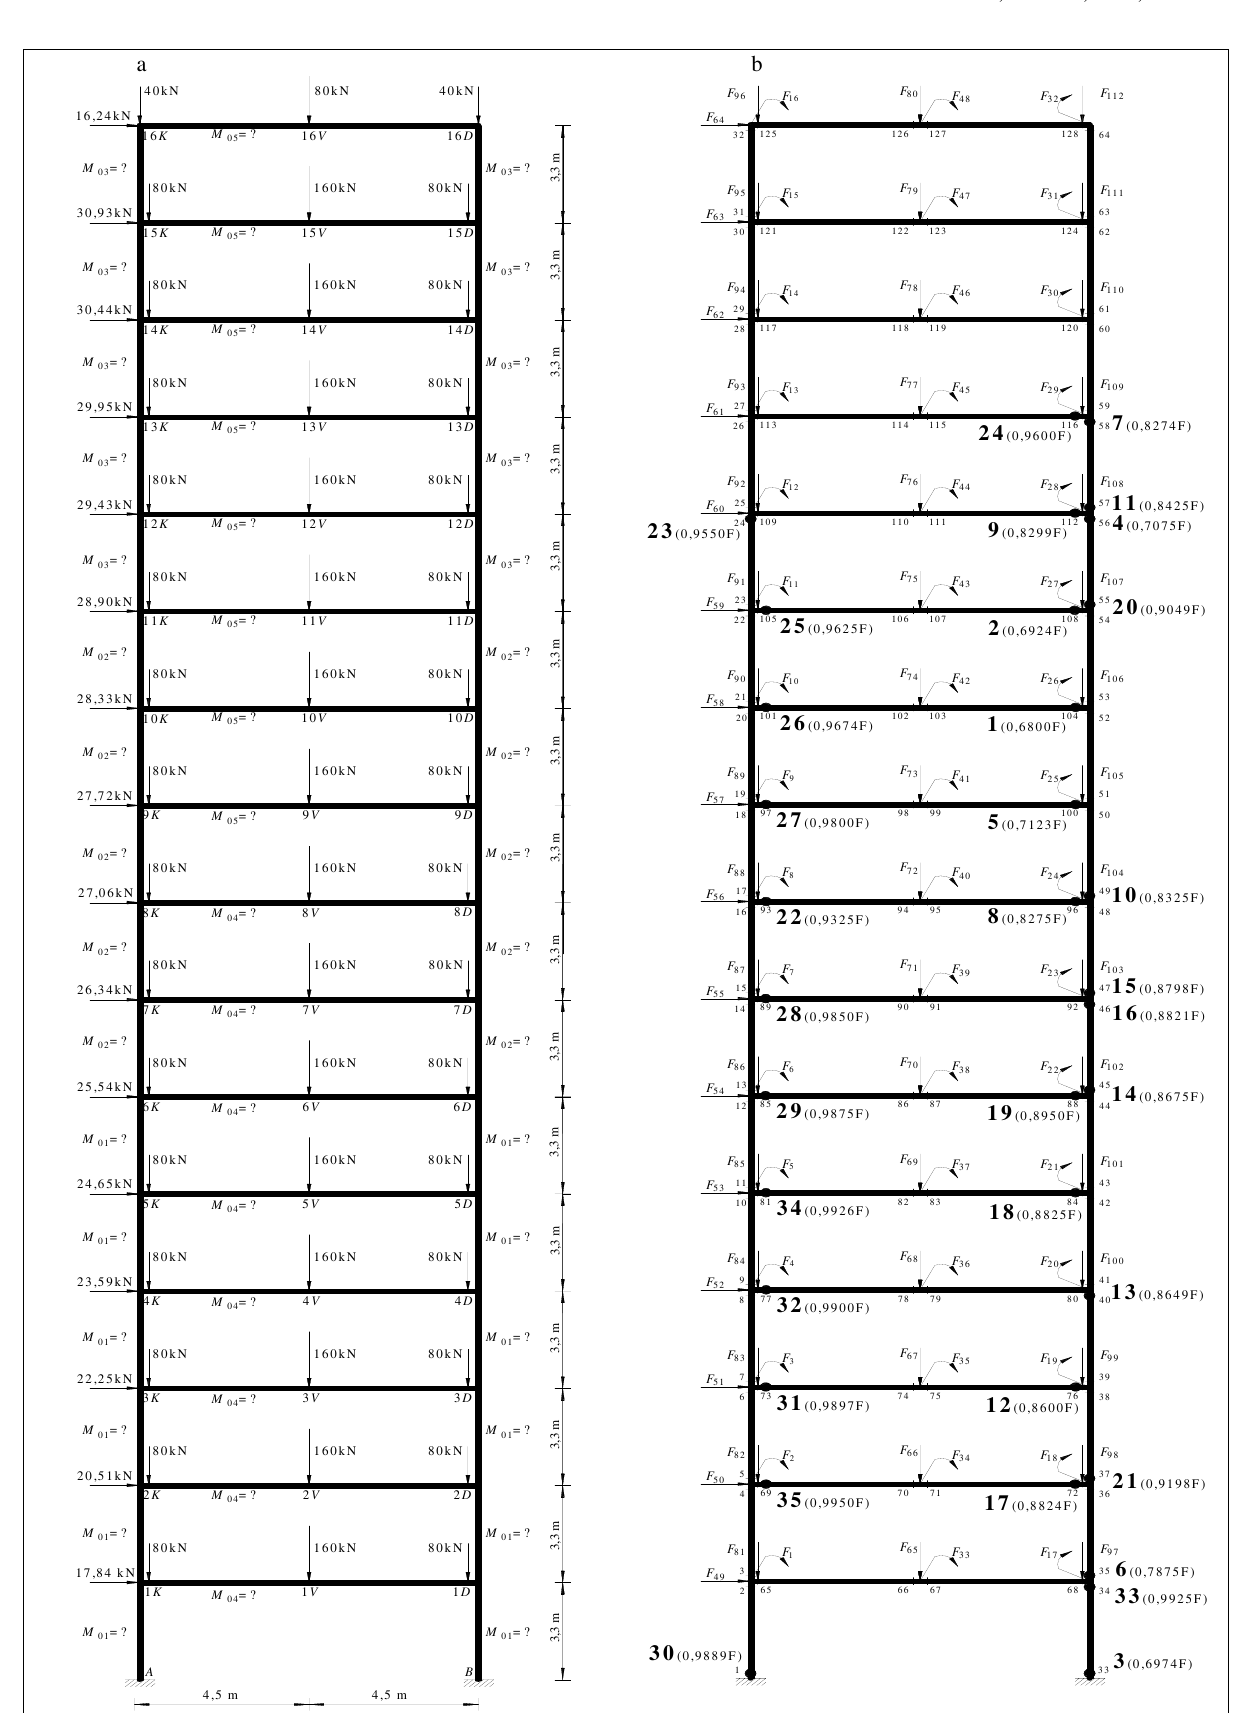
Fig 4. 16-storey steel frame and discrete